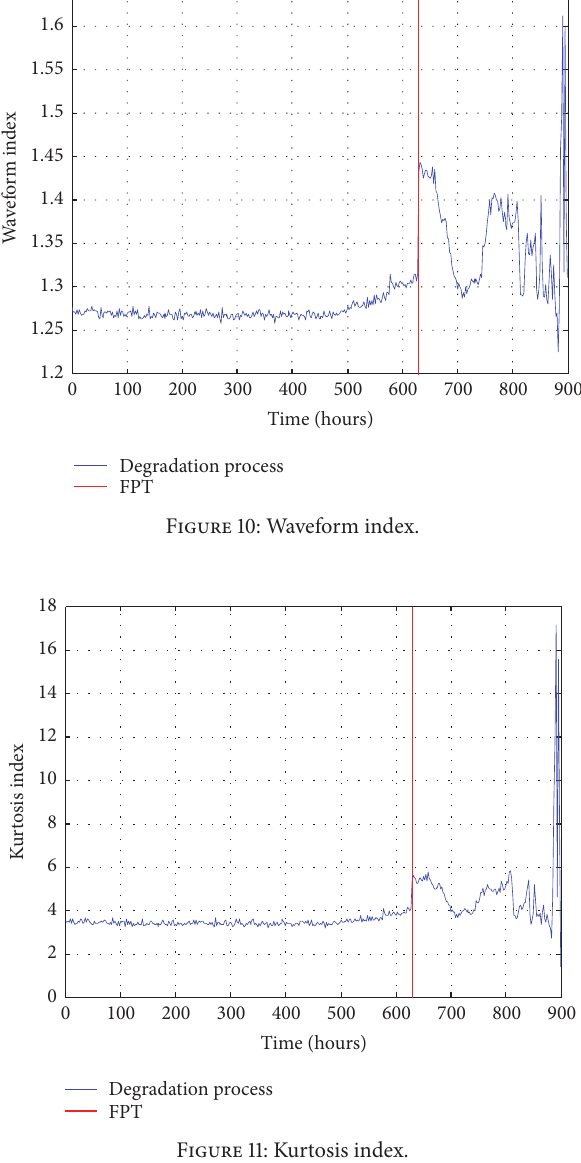
Figure 11: Kurtosis